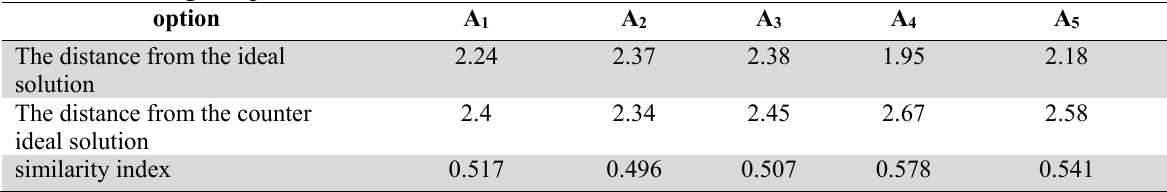
The final ranking of options option 1 A The distance from the ideal solution The distance from the